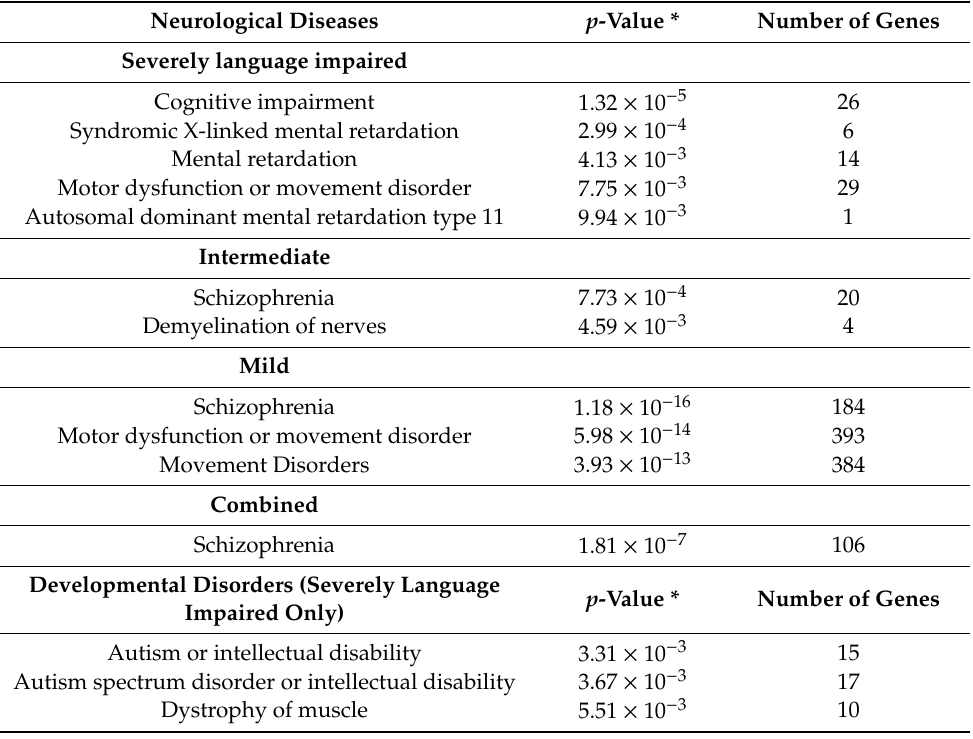
Table 2. Significantly over-represented neurological and developmental disorders among DAGs from the three phenotypic subgroups of ASD and the combined case